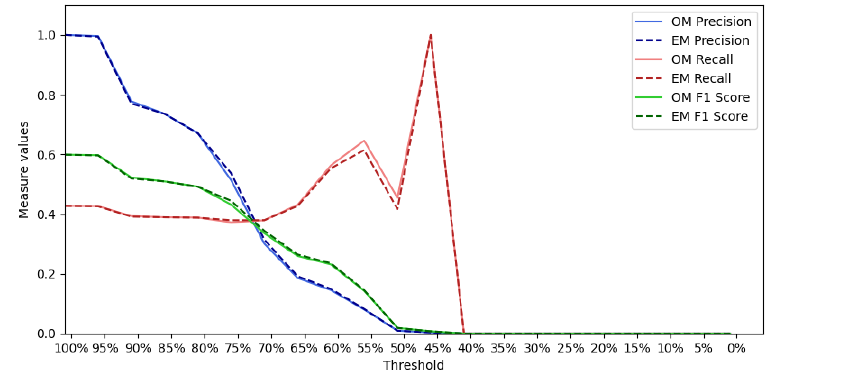
Figure 19. Results of the event “Sydney